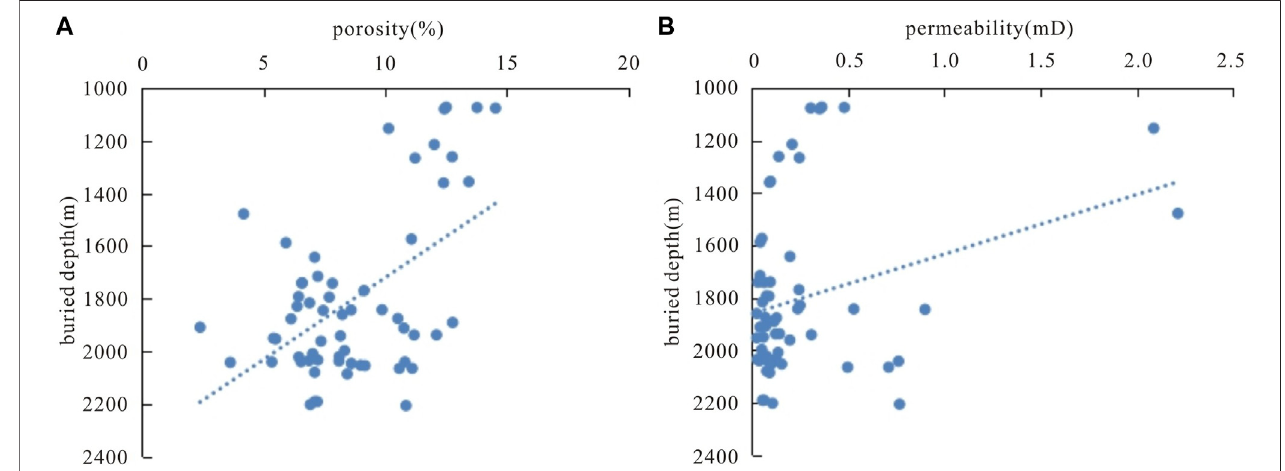
FIGURE 8 | Scatter plot of buried depth with reservoir porosity (A) and permeability (B) .